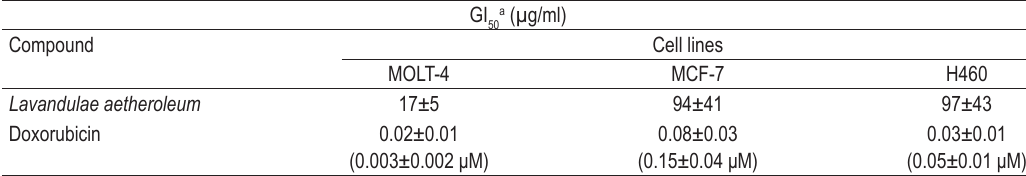
values (in µg/ml) 50